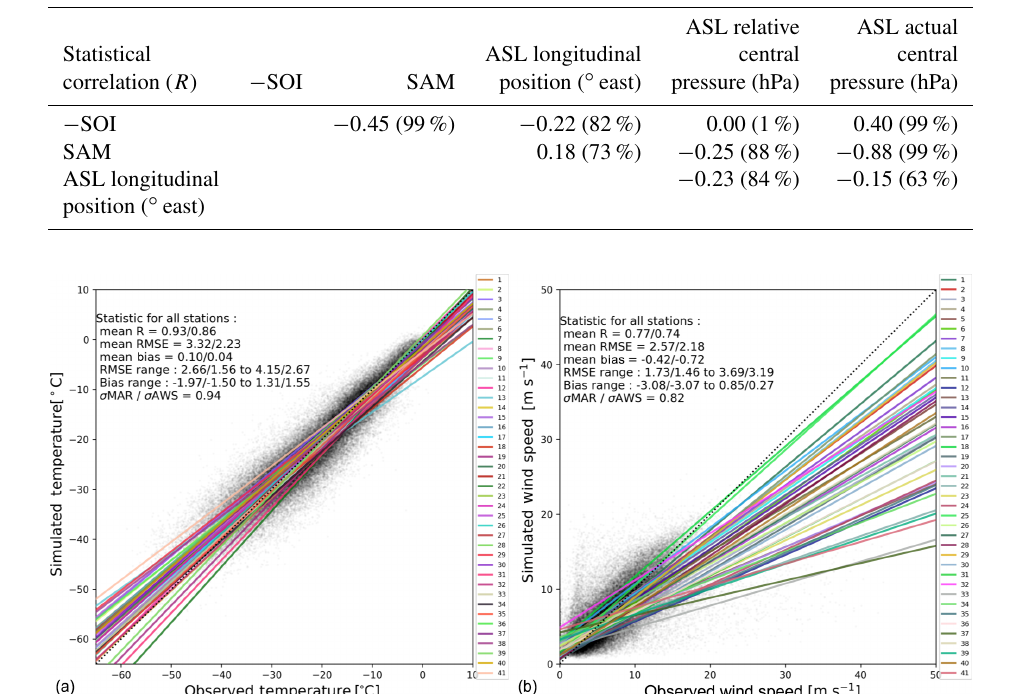
Table 1. Correlation between climate indices ( − SOI, SAM, ASL longitudinal position, ASL relative central pressure, ASL actual central pressure) in austral summer (DJF). Values in brackets represent the percentage of significance.